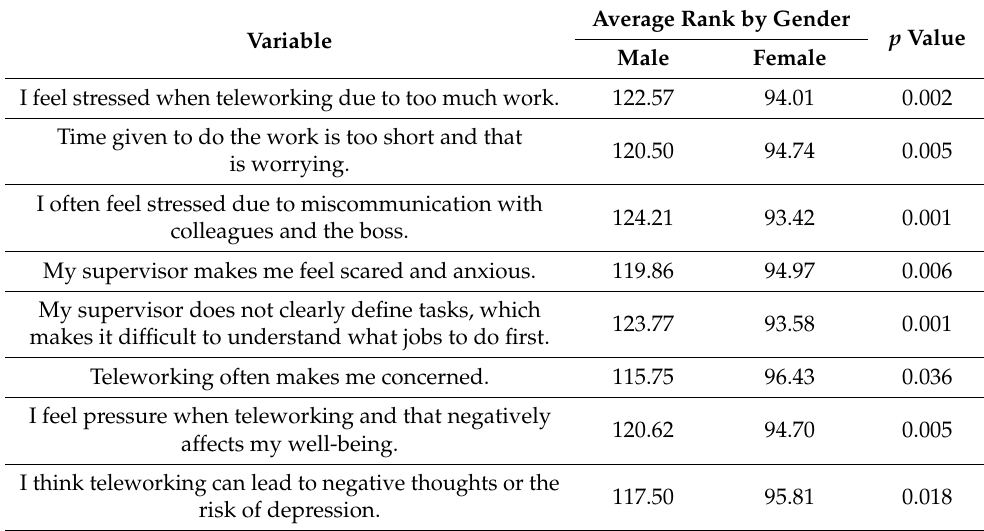
Table 8. Causes of stress when teleworking by